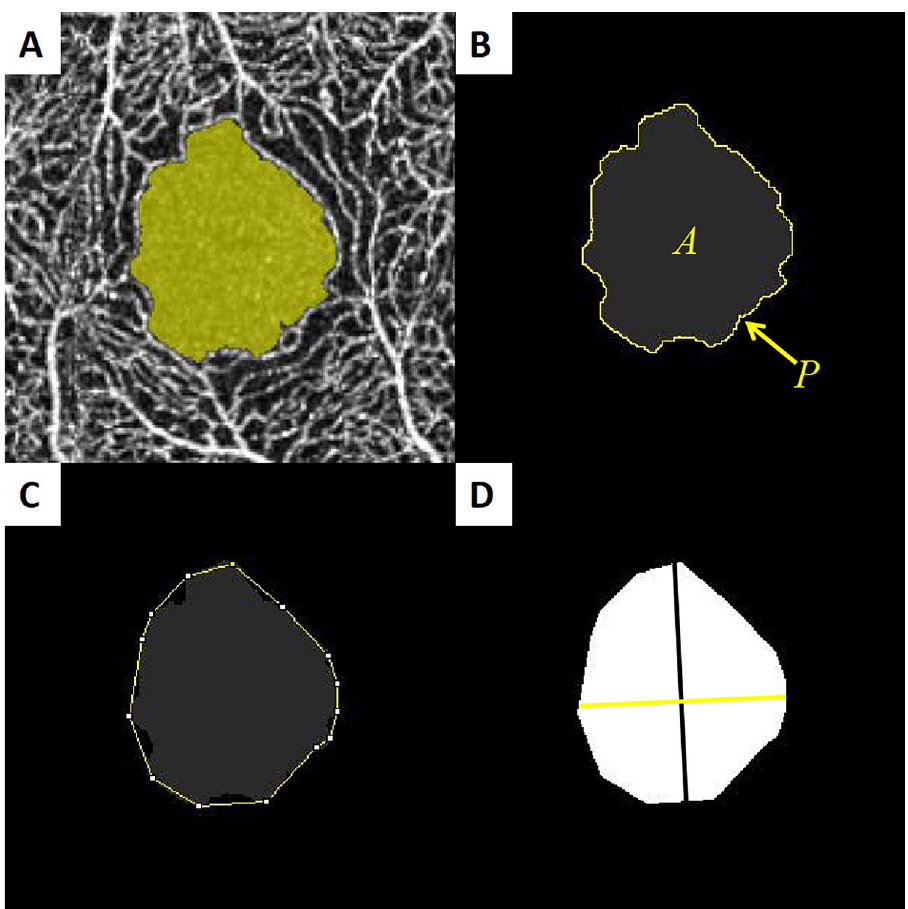
Figure 3. ( A ) Optical coherence tomography angiogram of the foveal avascular zone (FAZ) in superficial layer. ( B ) The FAZ was separated from the background image and the area ( A ) and perimeter ( P ) were automatically measured using the ImageJ software. ( C ) Outline was manually fit using the ImageJ software. ( D ) The major axis (black line) and minor axis (yellow line) lengths were also manually